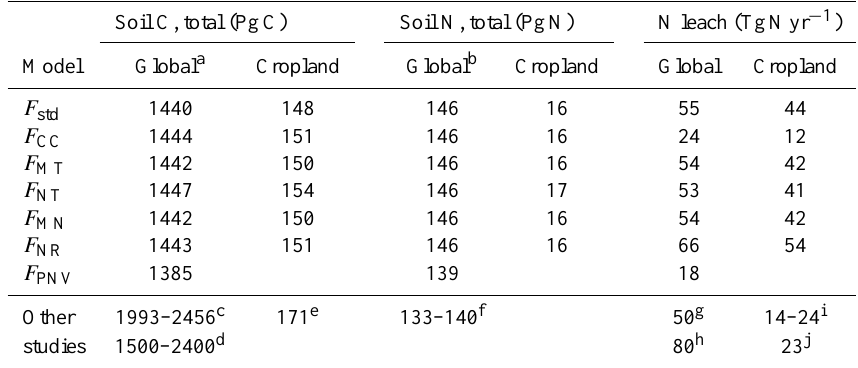
Table 4. Modelled global, total land and cropland soil C and N stocks and total N leaching (inorganic and organic) for the time period 1996–2005, compared to estimates from the literature. References for the studies and explanations of how some of the values were derived can be found in the notes of this table. See Table 2 for abbreviations.